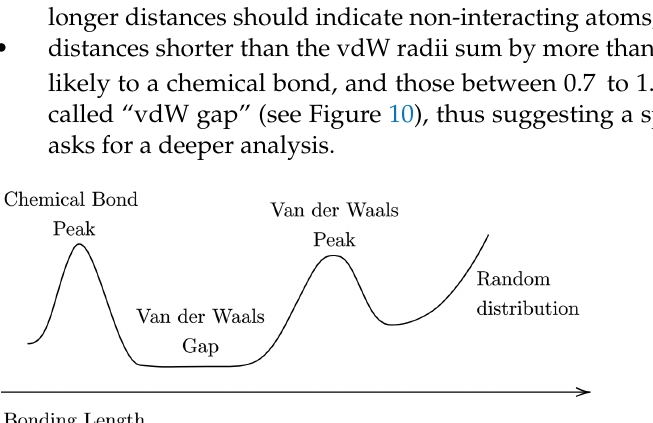
Figure 10. Pictorial scheme of a general atom-atom bonding length distribution, as described by Alvarez